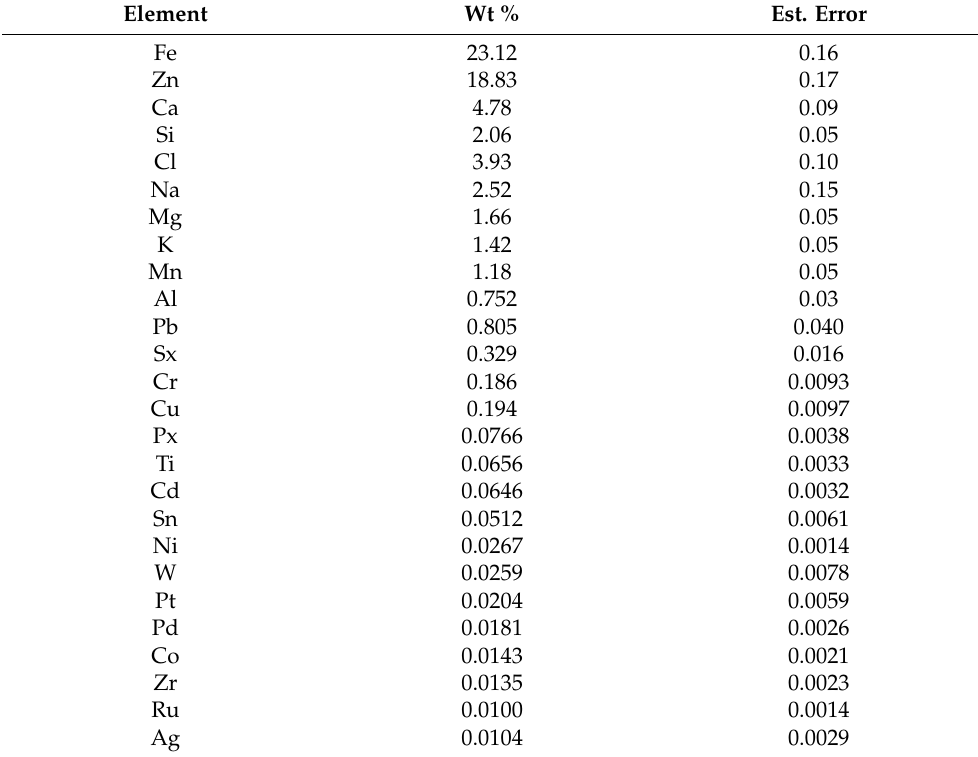
Table 2. X-ray fluorescence of electric arc furnace